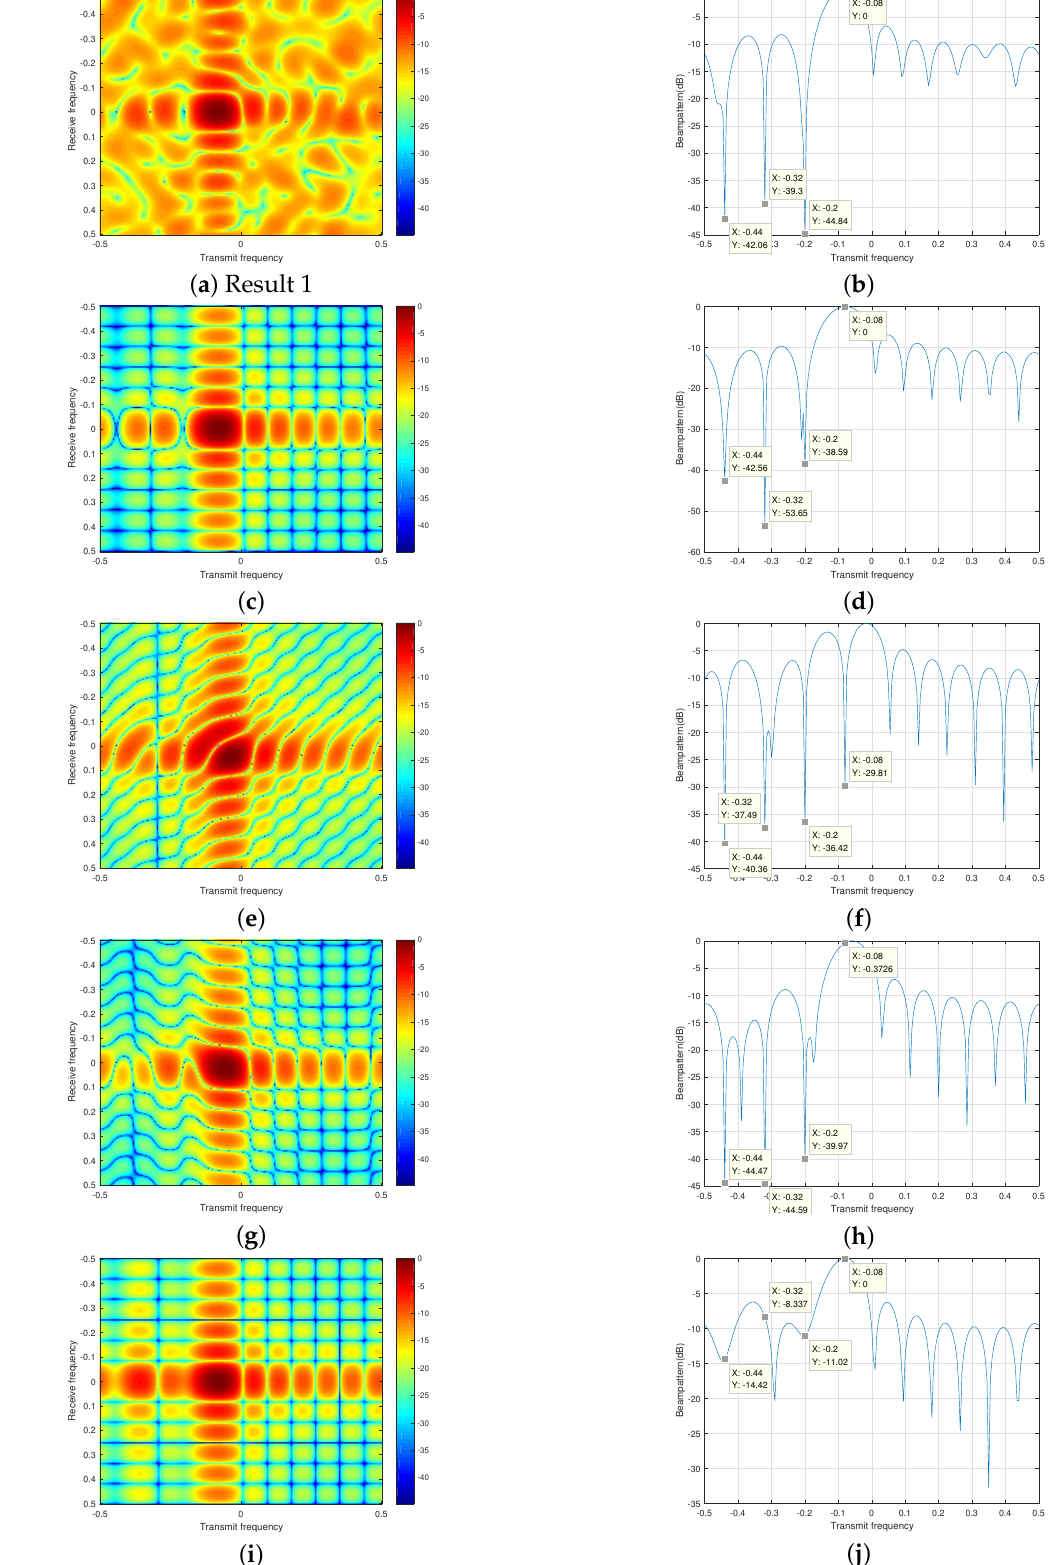
Figure 5. Beam-patterns of different methods in the transmit-–receive domain and cross sec- tion at f r = 0 (SNR = 30 dB). ( a , b ) Optimal, ( c , d ) proposed method (with the SV estima- tion process), ( e , f ) LSMI-MVDR, ( g , h ) proposed method (without the SV estimation process), ( i , j ) Eigenspace